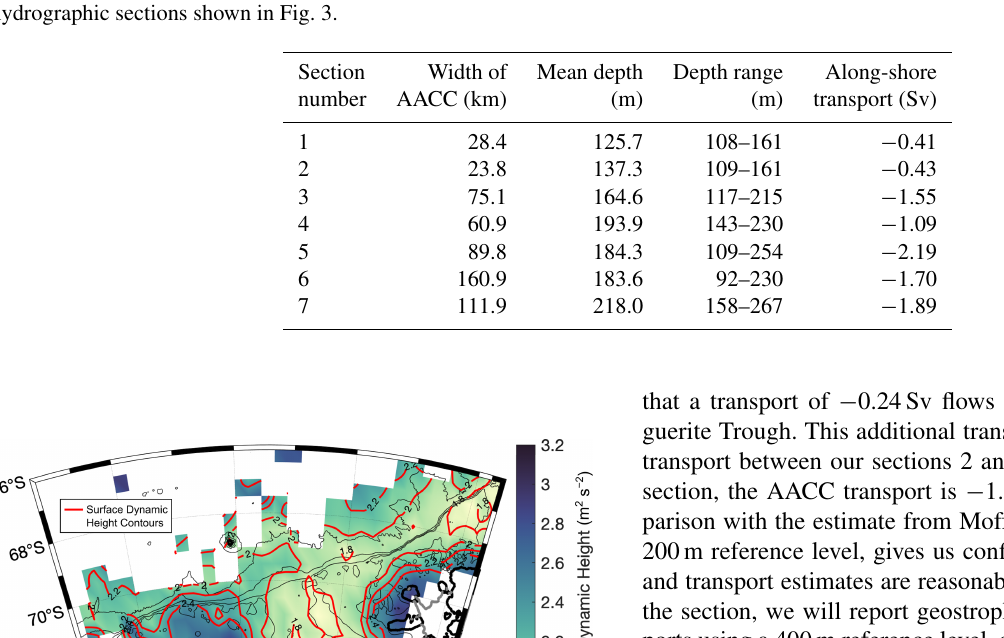
Figure 7. Vertical profiles of density stratification N 2 , averaged across the AACC, for the seven composite sections in Fig. 3. The sections are arranged from east (left) to west (right). Table 2. Width (kilometers), mean depth (meter), range of depth (meters) and along-shore transport for the AACC in each of the seven hydrographic sections shown in Fig. 3.